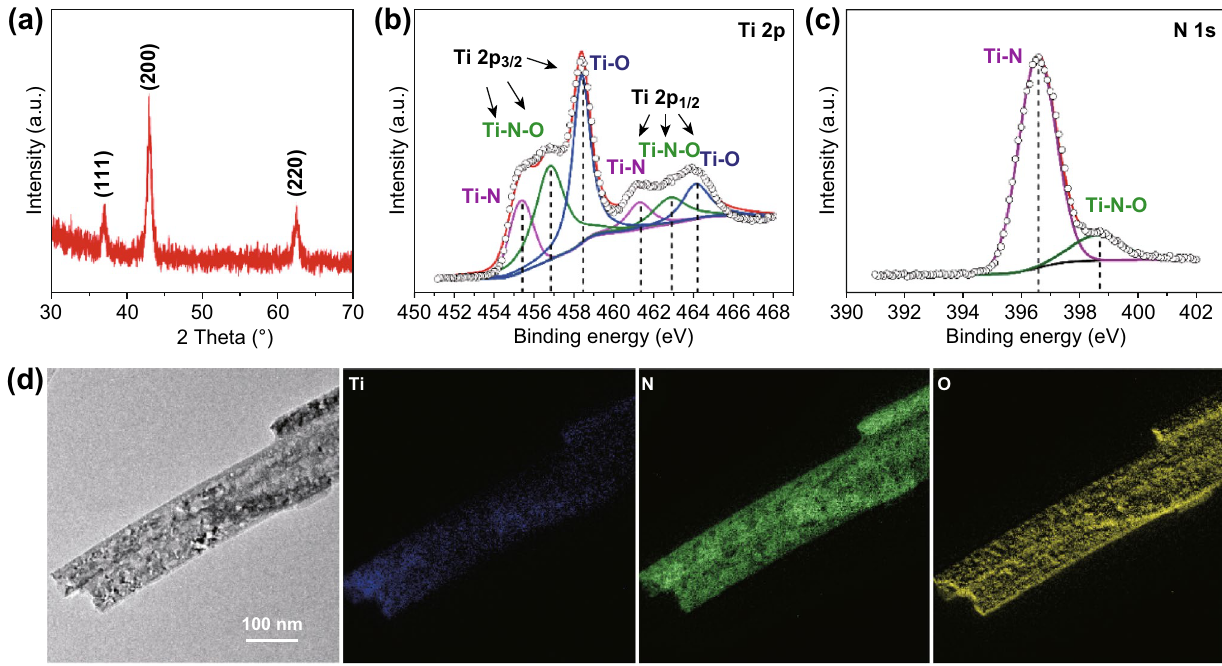
Fig. 2 a XRD pattern and b , c Ti 2p and N 1s XPS spectra of TiN paper. d TEM image and the corresponding Ti, N, and O elemental mapping images of TiN